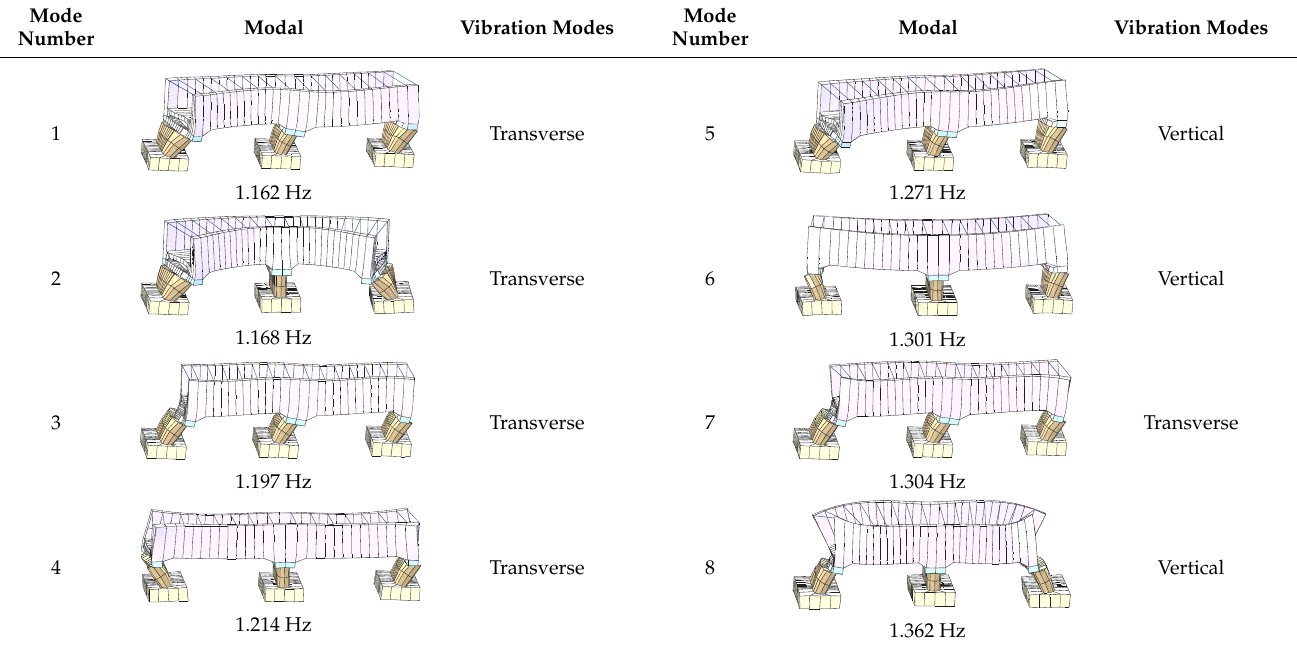
Table 2. The first eight frequencies and vibration modes of the aqueduct structure.